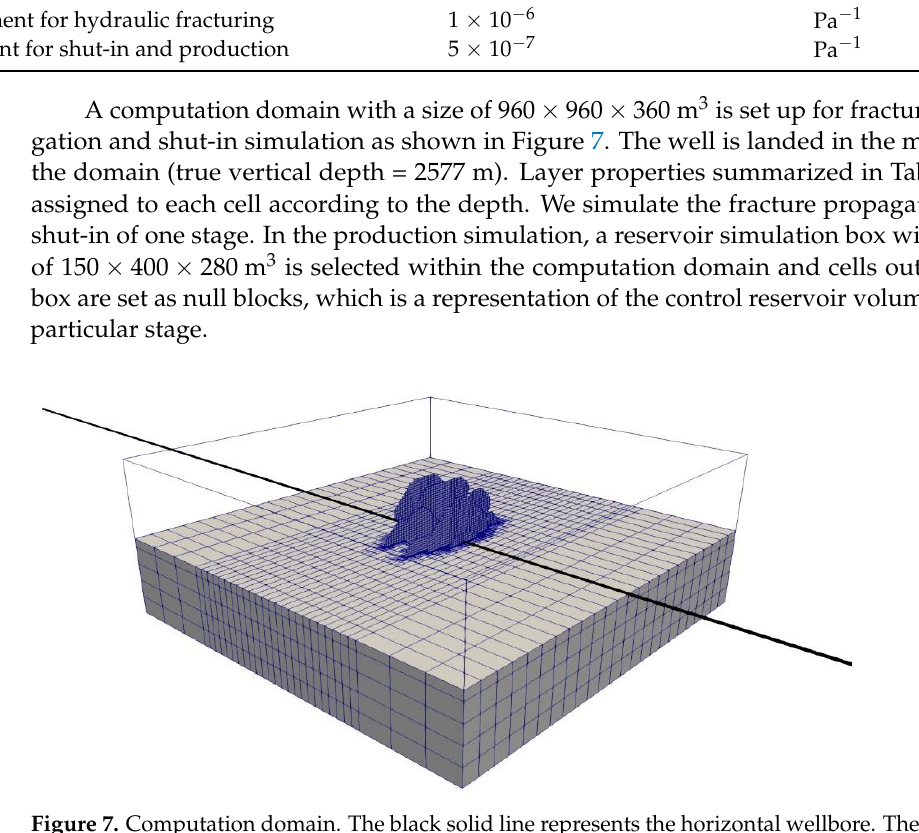
Figure 7. Computation domain. The black solid line represents the horizontal wellbore. The reservoir mesh for the lower-half of the domain and the fracture mesh for the upper-half of the domain are shown in the figure.